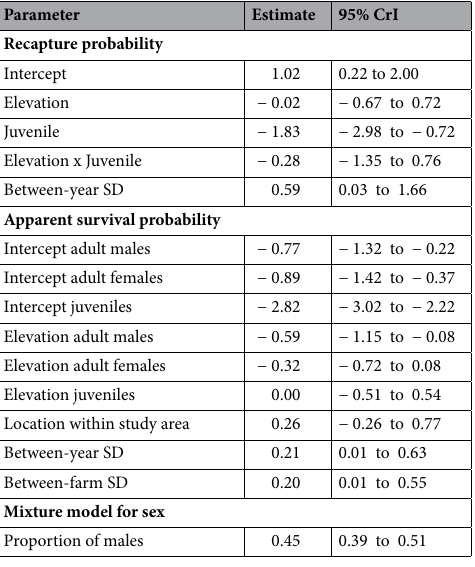
Table 1. Parameter estimates (mean of the posterior distribution) of the survival model with 95% credible intervals (CrI). Estimates for recapture and apparent survival probability are on the log-odds scale. Estimated proportion of males among the non-identified individuals is on the proportion scale. N = 1531 ringed individuals (1337 nestlings, 194 adults) and 89 recaptured